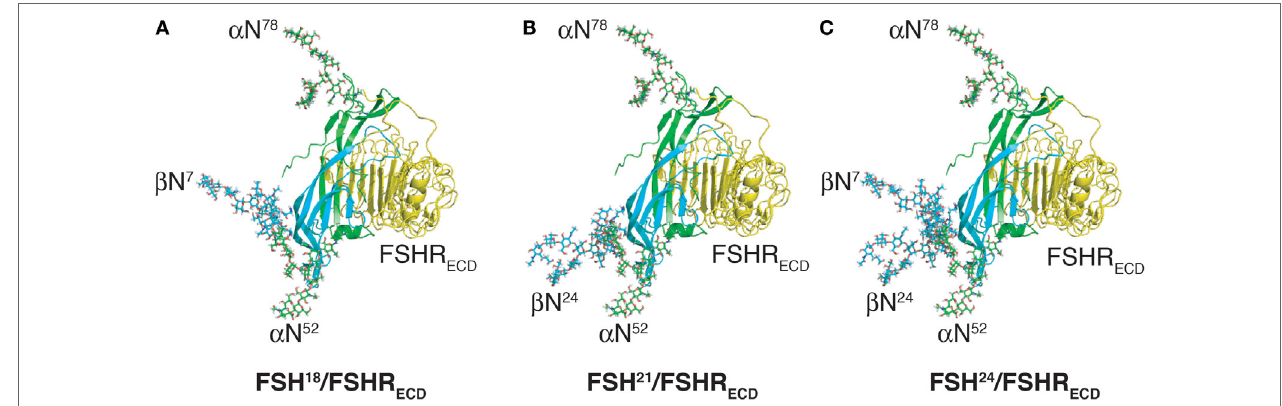
FiGURe 5 | Follicle-stimulating hormone (FSH) glycoform models bound to monomeric FSH receptor (FSHR) extracelluar domain model (FSHR ECD ). FSH glycoform models are oriented as in Figure 2 . The FSHR ECD model was extracted from pdb 4AY9 and rendered as cartoon using MacPyMOL. The FSH glycoform models were aligned to the FSH model extracted from the pdb file along with the FSHR ECD to illustrate the positions of oligosaccharides relative to the high-affinity binding site in the FSHR. (A) Glycosylated model of FSH 18 and FSHR extracellular domain. (B) Glycosylated model of FSH 21 and FSHR extracellular domain. (C) Glycosylated model of FSH 24 and FSHR extracellular